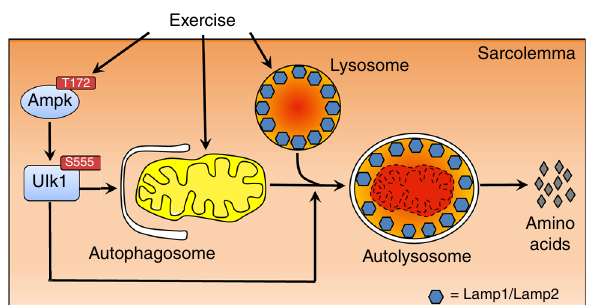
Fig. 8 Acute exercise-induced mitophagy is regulated through the Ampk- Ulk1 signaling axis. Ampk activation through phosphorylation at T172 is required for exercise-induced phosphorylation of Ulk1 S555 and lysosomal biogenesis in skeletal muscle. Simultaneously, exercise initiates mitochondrial fi ssion, which is not dependent on Ampk activation. We demonstrate that Ulk1 is critical for targeting of the lysosome to